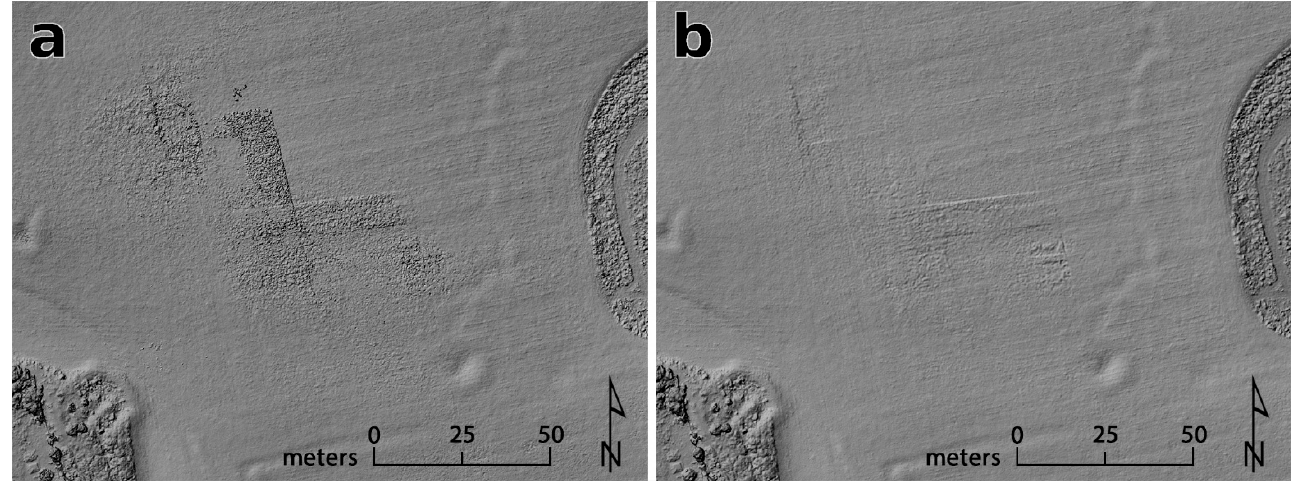
Figure 9. The 2.5D DSM computed from a meshed dense 3D point cloud ( a ) and directly from the merged depth maps ( b ). Notice the reduction of surface artefacts in ( b ). Both DSMs are rendered as hillshade with 55° solar azimuth and a 35° solar elevation.